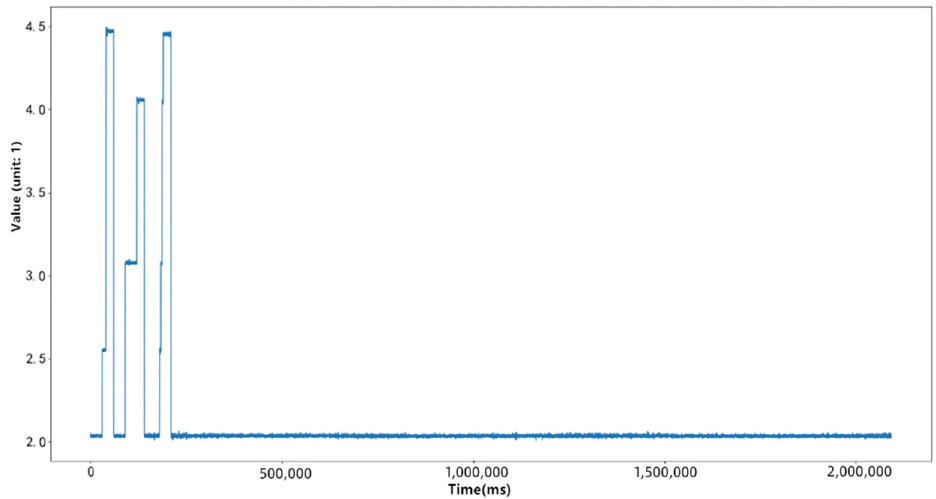
Figure 3. Original time series.